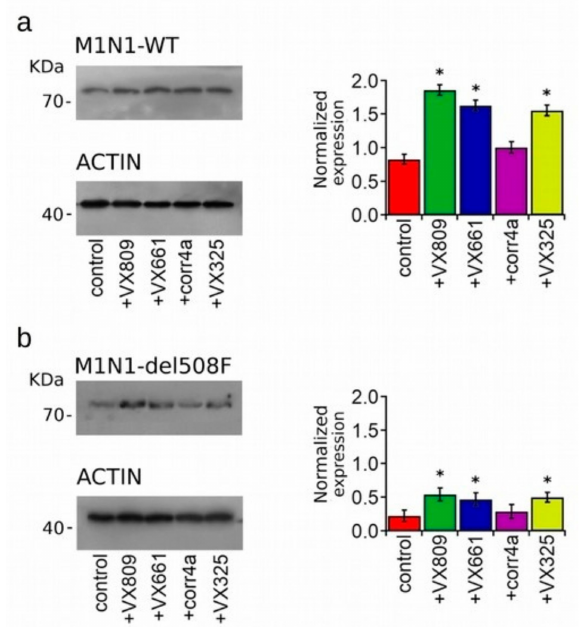
Figure 3. E ff ect of correctors on the expression of the CFTR N-half. Western blots of WT- ( a ) and F508del-M1N1 ( b ) transiently transfected in HEK-t cells treated with DMSO (control) or with 5 µ M VX809, 5 µ M VX661, 10 µ M corr4a and 5 µ M VX325. In the lower blots, the expression of actin, used